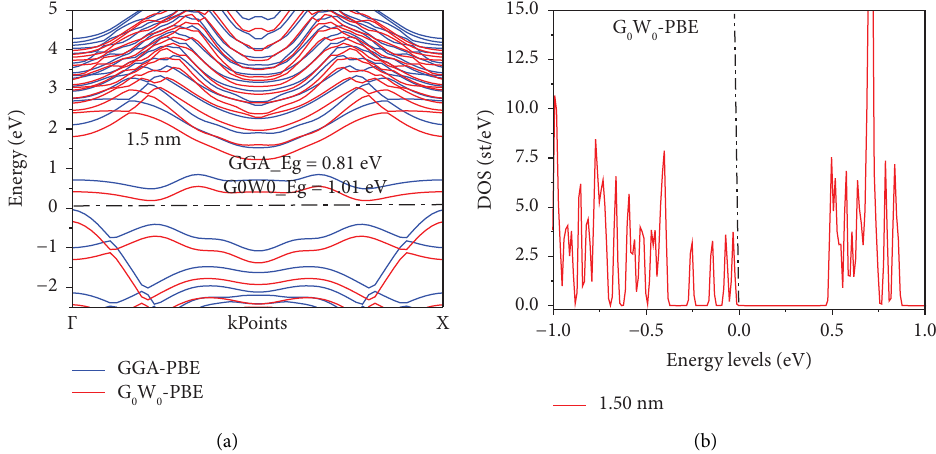
Figure 7: (a) Bands structure and (b) electronic density of states for CBNNT with 1.50nm